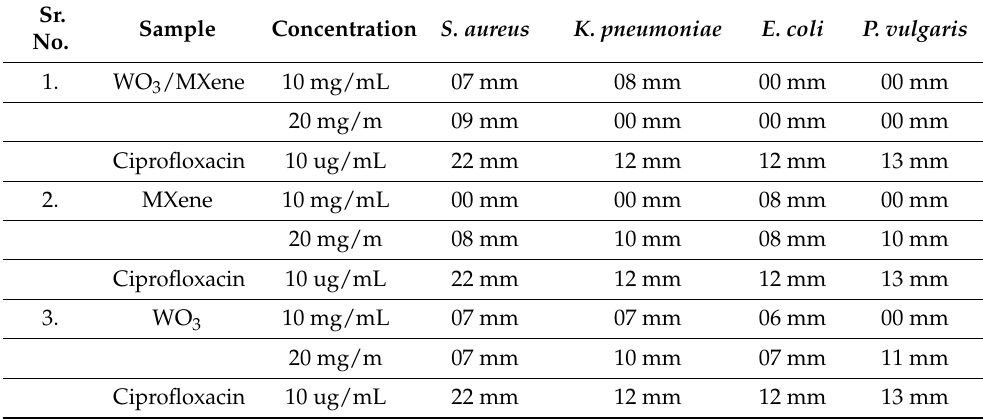
Figure 13. Antibacterial activity of ( a ) WO 3 , ( b ) Mxene and ( c ) WO 3 /Mxene against Staphylococcus aureus . Table 3. Results of antibacterial activity of as-synthesized